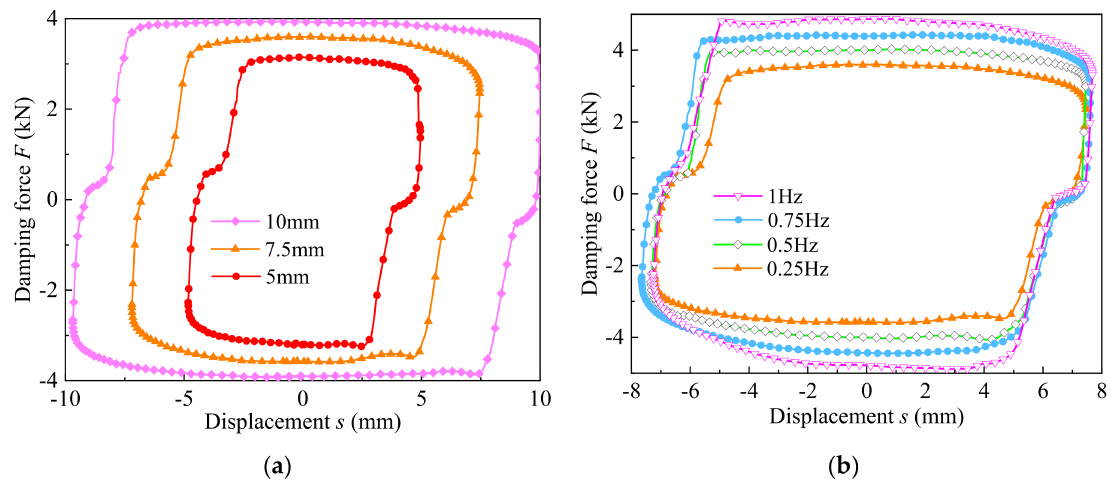
Figure 18. Damping force versus displacement: ( a ) under variation amplitudes, ( b ) under variation